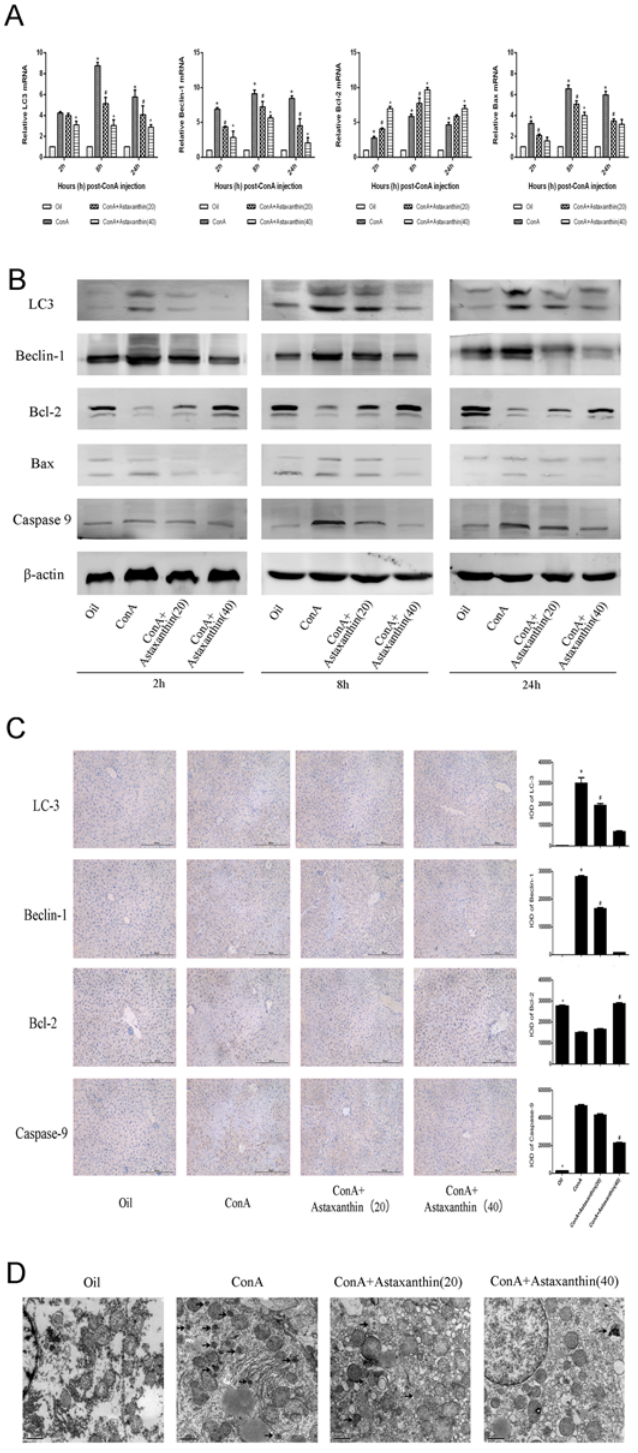
Fig 4. Effects of astaxanthin on apoptosis and autophagy in mice with ConA-induced acute hepatitis. (A) cDNA levels of LC3, Beclin-1, Bcl-2, and Bax were measured with real-time PCR (n = 8, * P < 0.05 for Oil versus ConA, # P < 0.05 for ConA+Astaxanthin (20) versus ConA, + P < 0.05 for ConA+Astaxanthin (40) versus ConA). (B) Protein expression of LC3, Beclin-1, Bcl-2, Bax, and caspase 9 was detected with western blotting. (C) Immunohistochemistry was used to detect LC3, Beclin-1, Bcl-2, and caspase 9